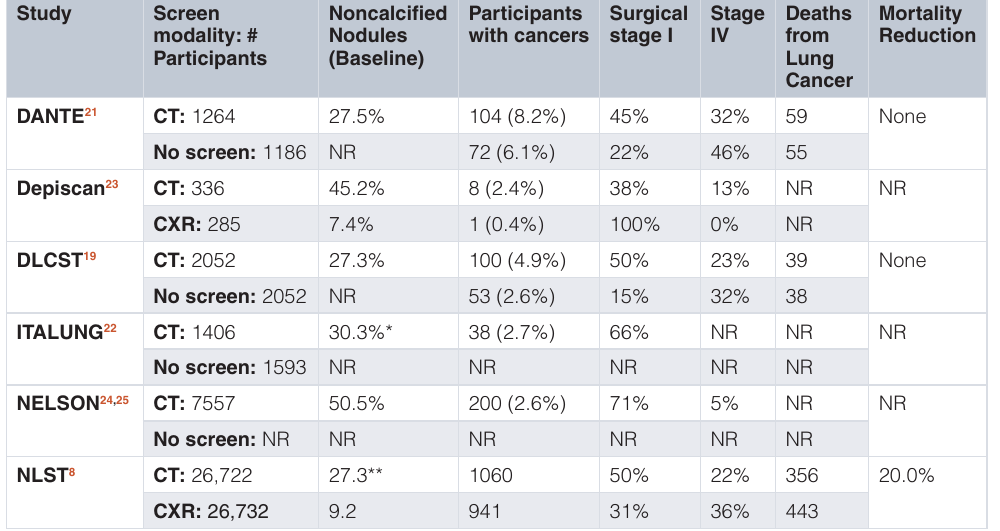
Table 1. Randomized controlled computed tomography screening